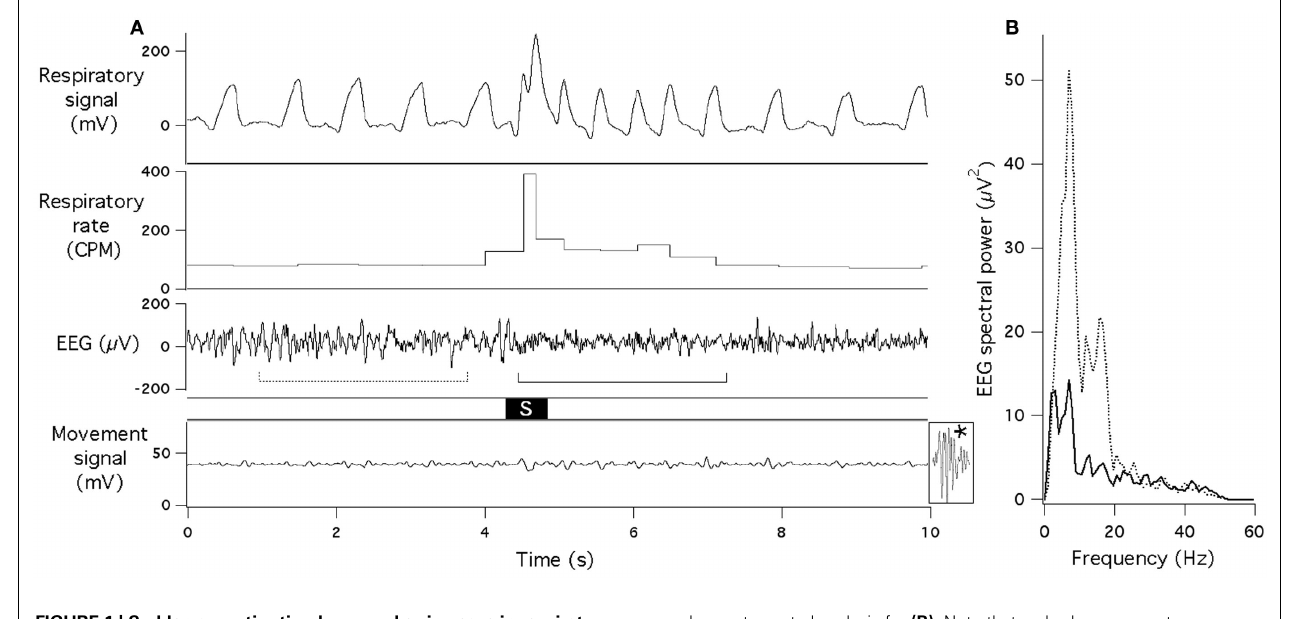
FIGURE 1 | Sudden acoustic stimulus provokes increase in respiratory rate and EEG desynchronization. (A) Raw data records of respiratory signal, respiratory rate, EEG and gross motor movements (piezoelectric sensor). Acoustic stimulus (60dB, 0.5s white noise) is marked “S.” Dotted and solid lines under the EEG record indicate data segments that